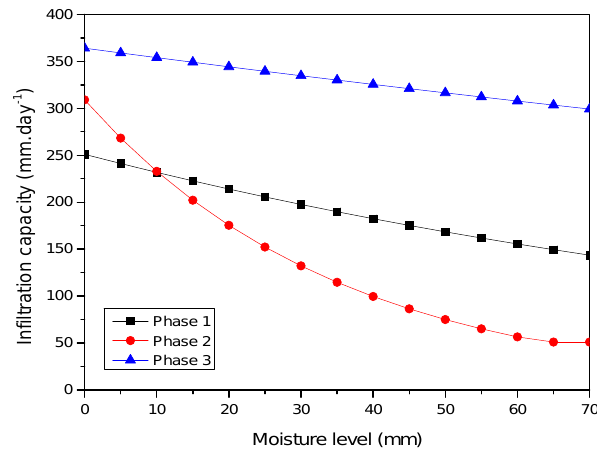
Figure 4. The infiltration capacity as a function of moisture con- tent relationship for the SimHyd model (Phase 1: August 1970– July 1990; Phase 2: August 1990–July 1994; Phase 3: August 1994– July 2006).